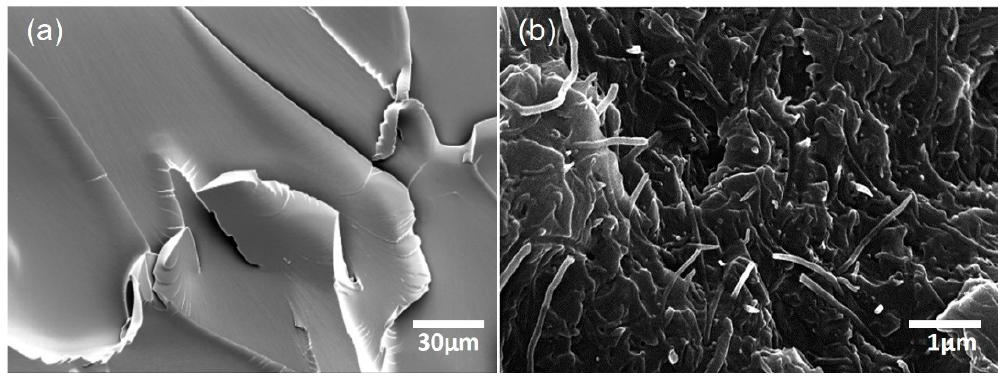
Figure 3. Scanning electron microscope (SEM) images of ( a ) pristine epoxy and ( b ) CNT / epoxy composite (2.0 wt %).